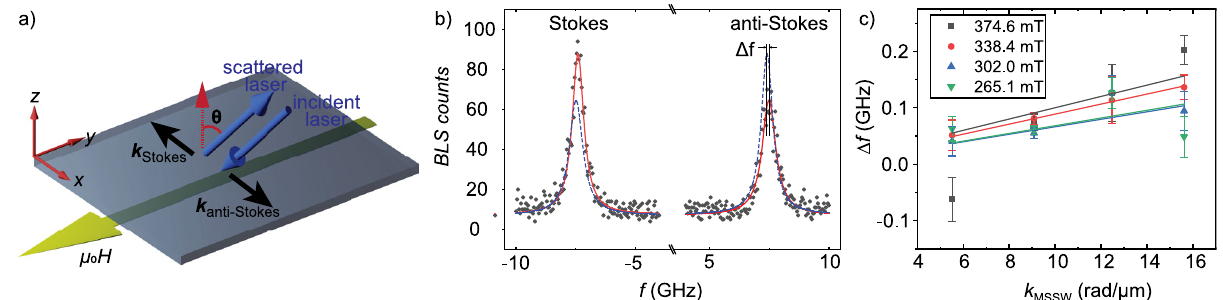
Fig. 8 Brillouin light scattering measurements. a Schematic diagram of backscattering geometry of the BLS measurement. The magnetic fi eld was applied along the y axis. Data were taken in backscattering geometry with different angles θ with respect to the z axis. b BLS spectra of magnetostatic surface spin waves (MSSW) when μ 0 H = 338.4 mT at θ = 20°. Gray dots are the experimental data collected by BLS. Red lines are fi tted curves with Lorentz function. Blue dash lines are the mirror curves of the red lines. Δ f is the frequency difference between Stokes and anti-Stokes peaks. c Frequency differences Δ f obtained at different fi eld values. Solid lines are linear fi